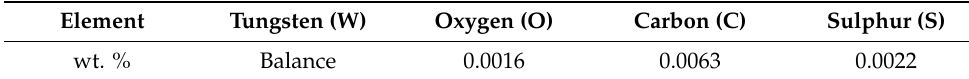
Table 1. Chemical composition of tungsten powder (wt. %).